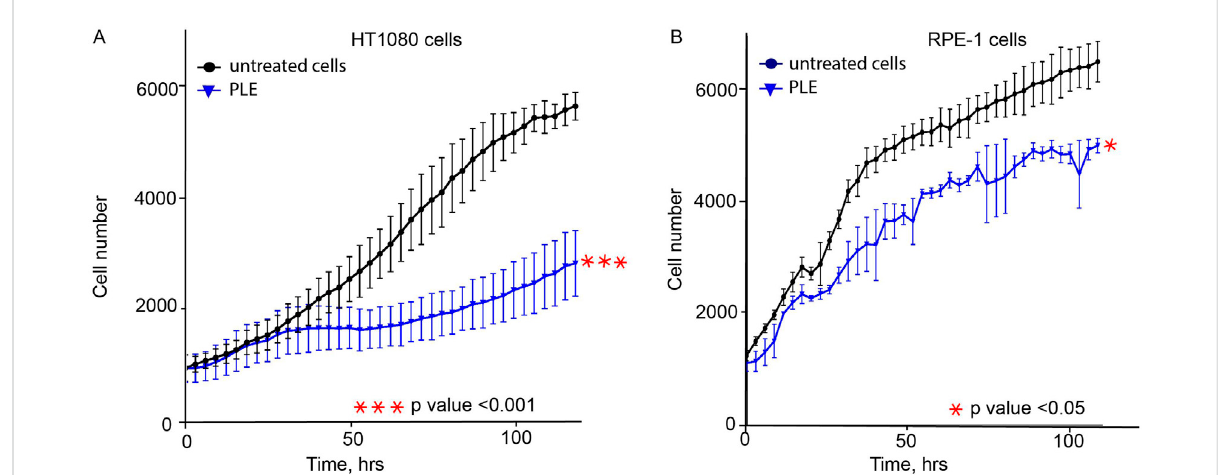
The proliferation rate of HT1080 (A) and RPE-1 (B) cells treated with PLE. Cells were treated for 24 h, then media was replaced, and cell proliferation was recorded by live imaging for 120 h. PLE — P. granatum leaves. Each cell line was compared to a negative control: HT1080